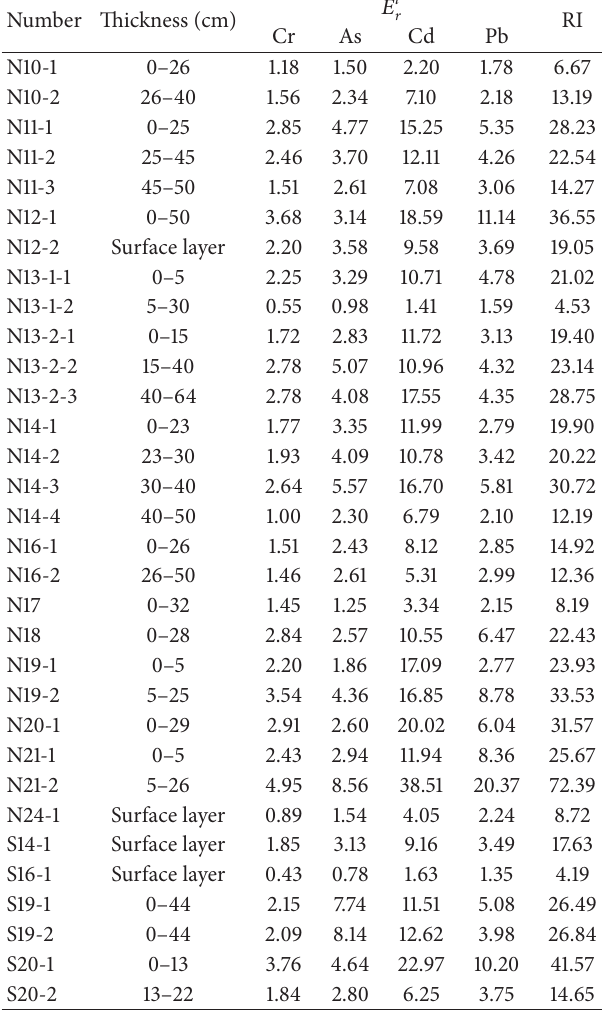
Table 7: Assessment of heavy metal potential ecological risks in